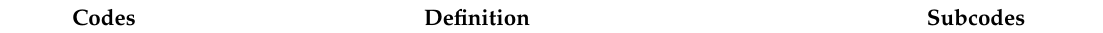
Table 2. Coding scheme.